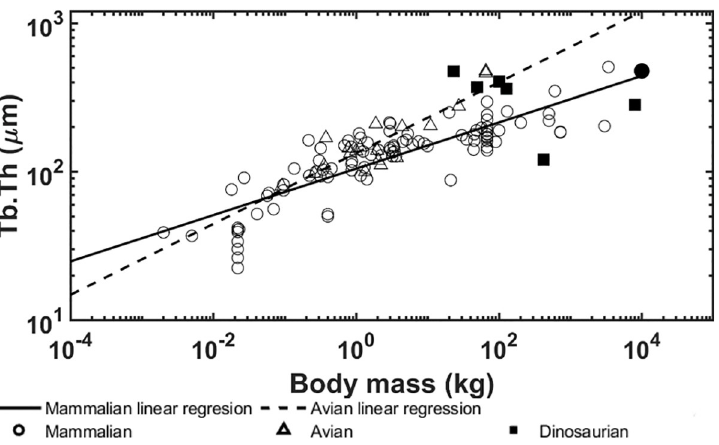
Fig 7. Logarithmically scaled plots of the trabecular thickness (Tb.Th) versus body mass. Pairwise comparisons indicate the dinosaur regression slope is different from the mammalian (p < 0.001) and avian (p < 0.001) slopes. The solid circle indicates the